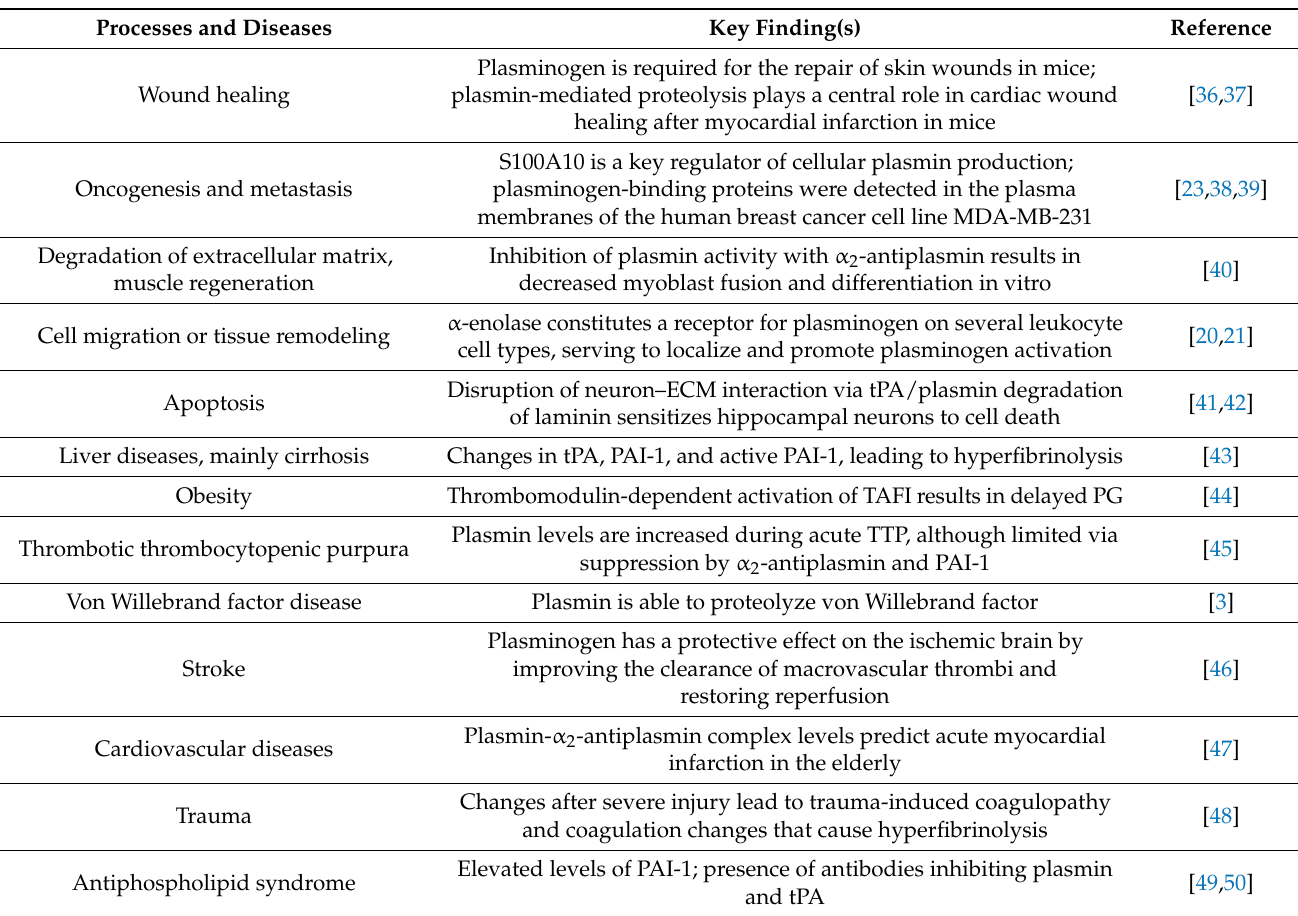
Table 1. Overview of the processes and diseases together with key findings where plasminogen and plasmin are involved. Processes and Diseases Key